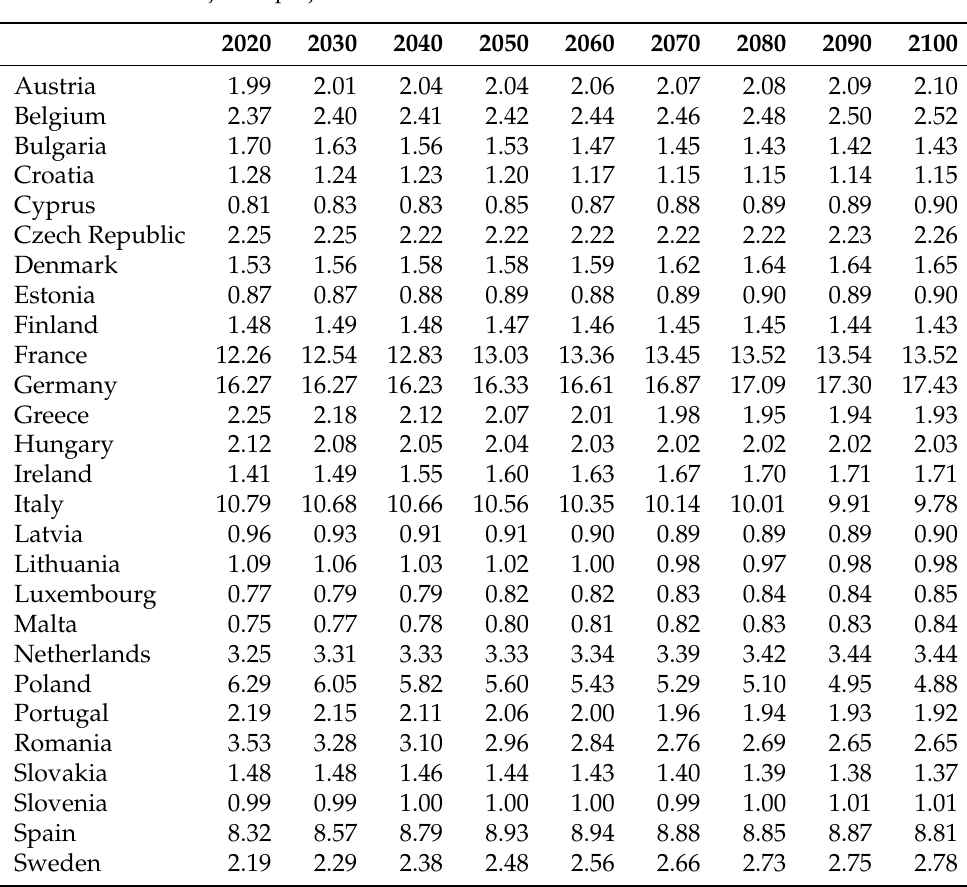
Table A4. Current adjusted projections after